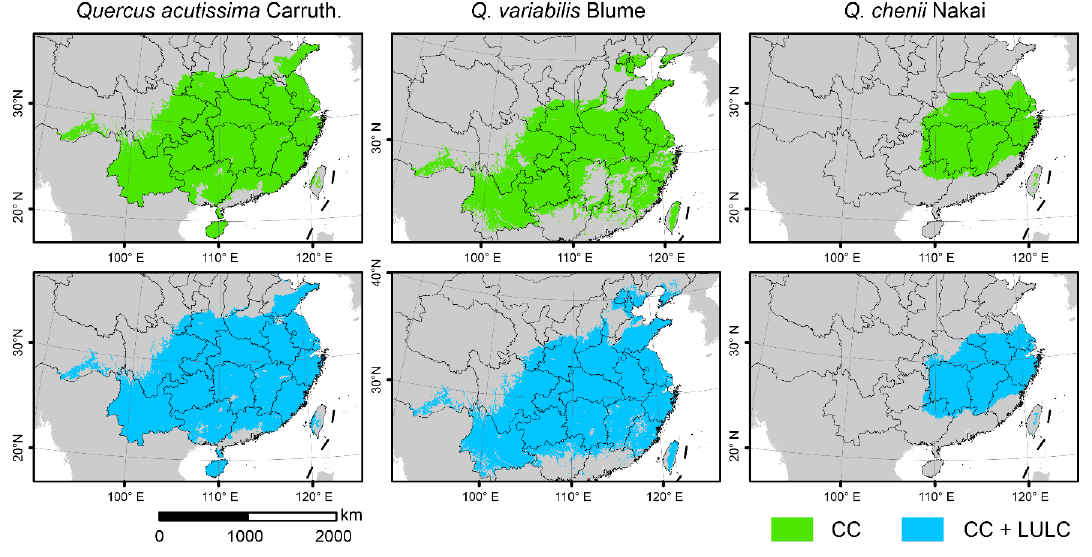
Figure 3. Current suitable habitats of the three East Asian Cerris oaks in China predicted by species distributions models (SDMs) only considering climate change (i.e., the CC model, green) and those considering CC as well as land use and land cover (LULC) change (i.e., the CC + LULC model, blue). The species-specific maximum training sensitivity plus specificity (MTSS) thresholds were used to classify the suitable habitats (>MTSS) and unsuitable habitats (<MTSS).